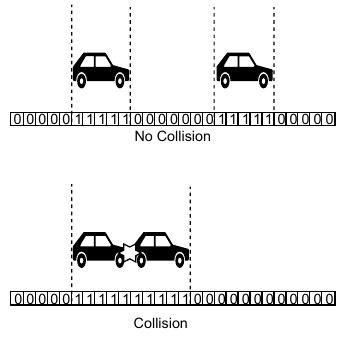
Figure 6. Lane collision